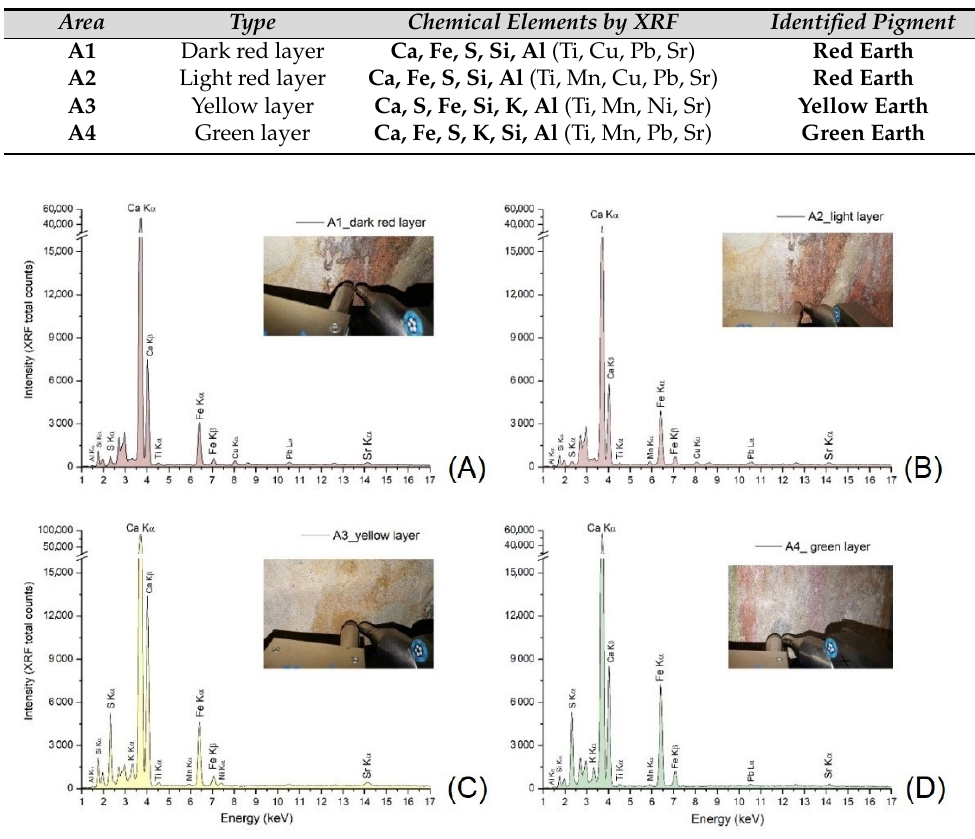
Figure 5. p-XRF spectra acquired on the “Virgin” mural painting; A1, Dark Red layer ( A ); A2, Light Red layer ( B ); A3, Yellow layer ( C ); A4, Green layer ( D ). Table 2. Portable X-ray fluorescence (p-XRF) elemental composition of “Virgin” mural painting. Notes: more abundant elements (in bold); minor or trace elements (in brackets).